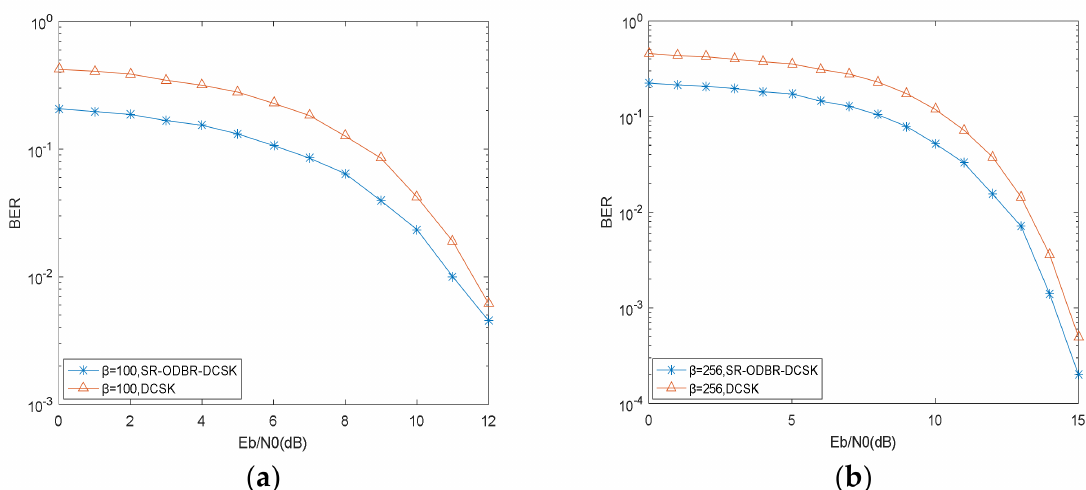
Figure 10. Comparison of BER of the DCSK system and the SR-ODBR-DCSK system. ( a ) β = 100; ( b ) β =